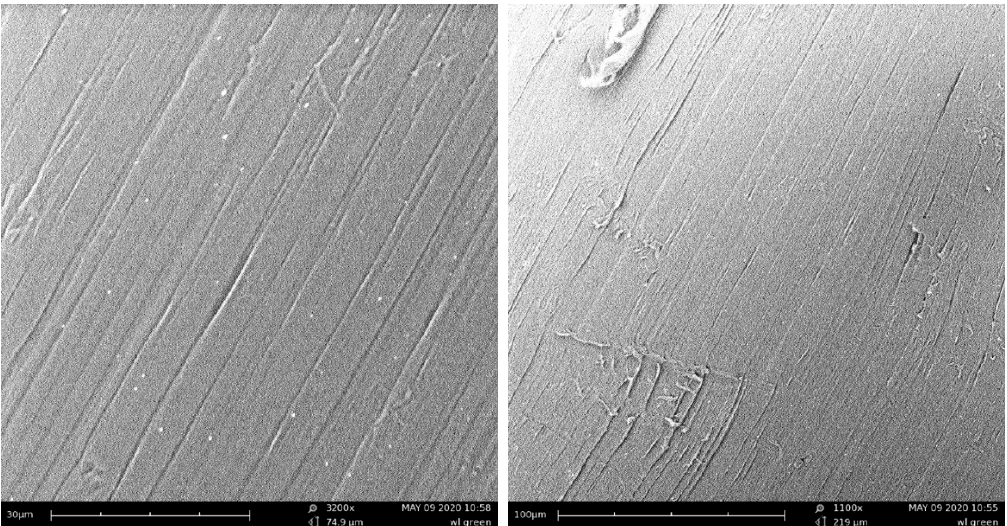
Figure 8. Scanning electron microscope (SEM) images of PPG.